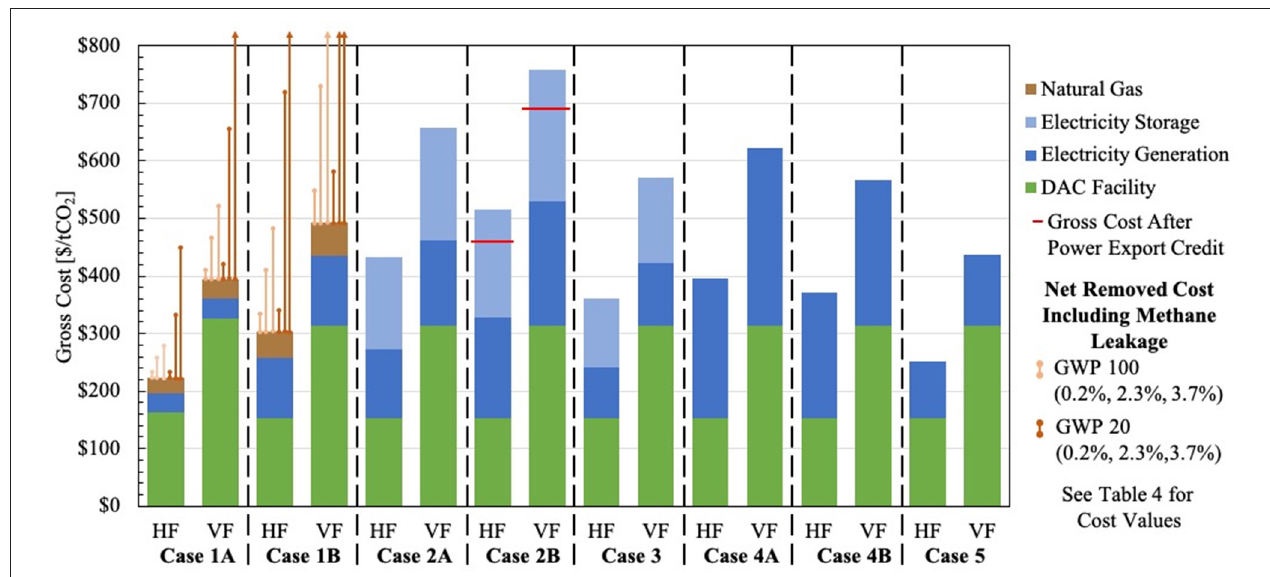
FIGURE 6 | Disaggregation of capture costs into their principal contributions: DAC component, energy component and storage component. The narrow vertical lines for Cases 1A and 1B show the net costs in Table 4 . Where these costs exceed $800/tCO 2 , the end is converted to an arrow and the lines are shown leaving the plot. The red, horizontal lines for Case 2B show the resulting net total cost after excess electricity is sold back to electricity